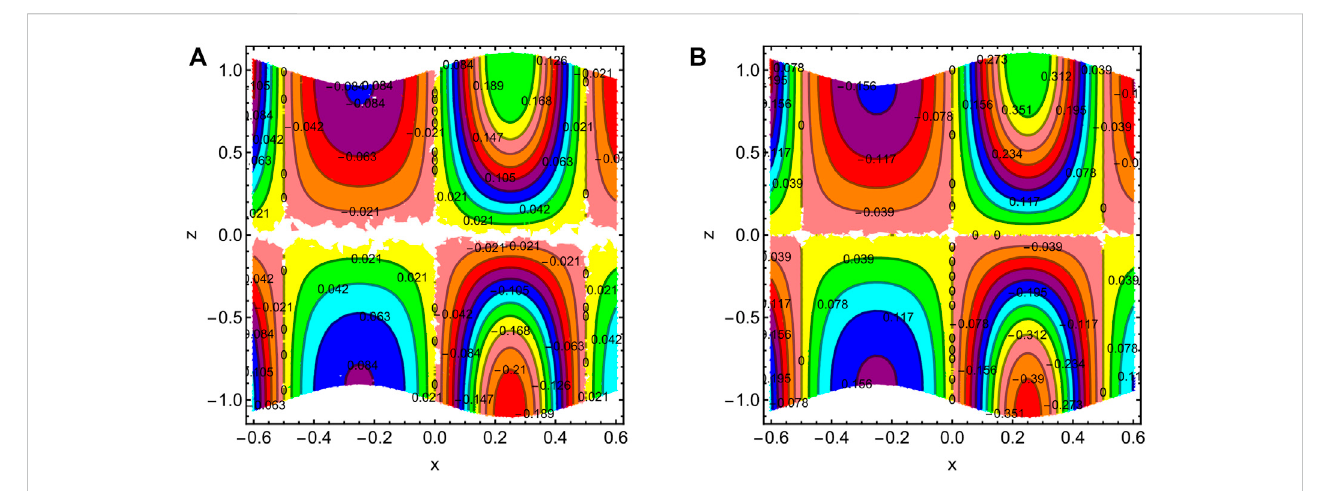
FIGURE 6 (A, B). Stream lines of u f for various values of γ ′ = .2 and